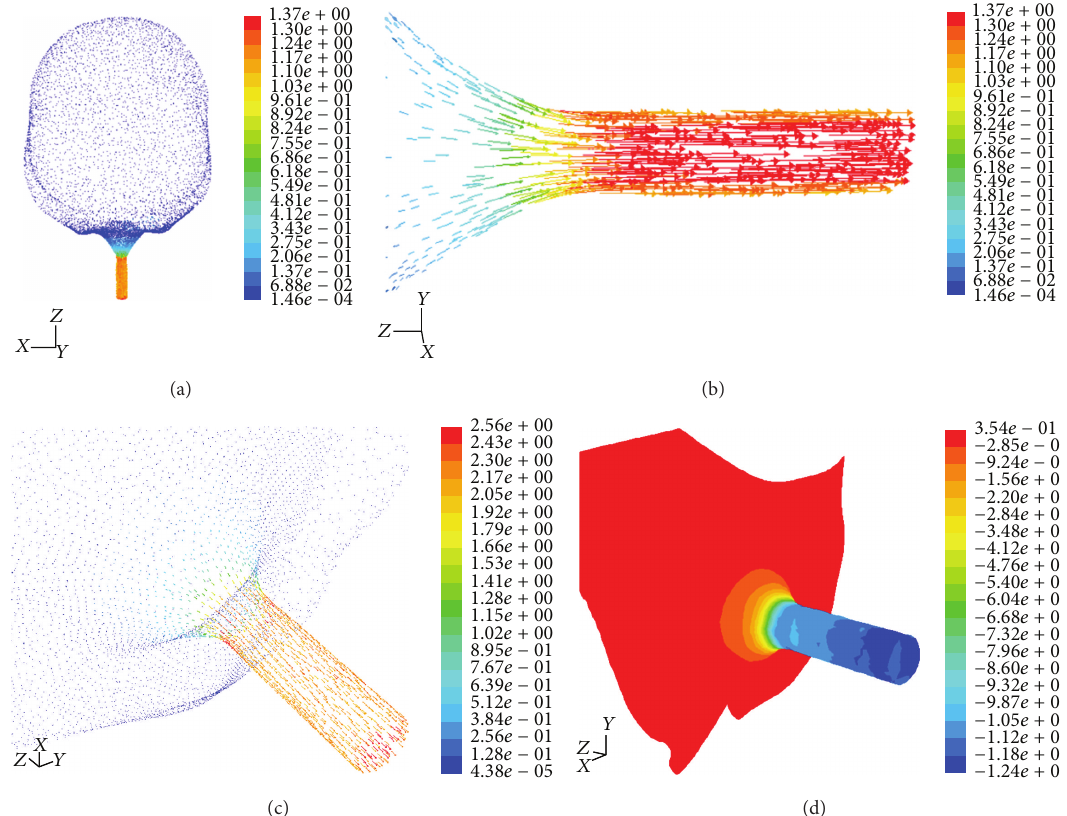
Figure 3: Urinary flow rate distribution in urinary bladder obtained from computational fluid dynamics (CFD) (velocity vectors colored by velocity magnitude